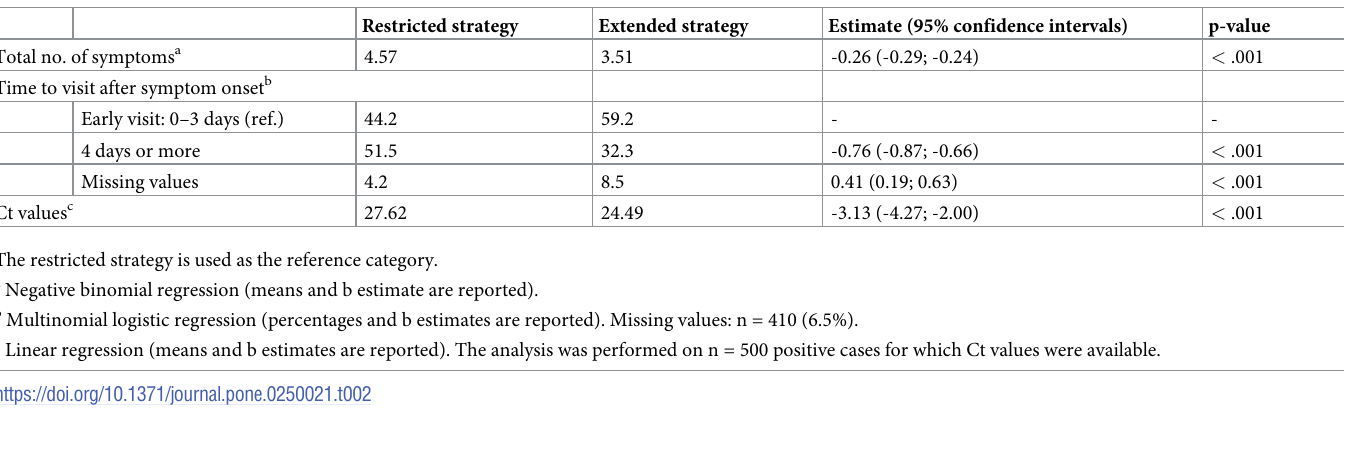
Table 2. Associations between testing strategies and symptoms (n =